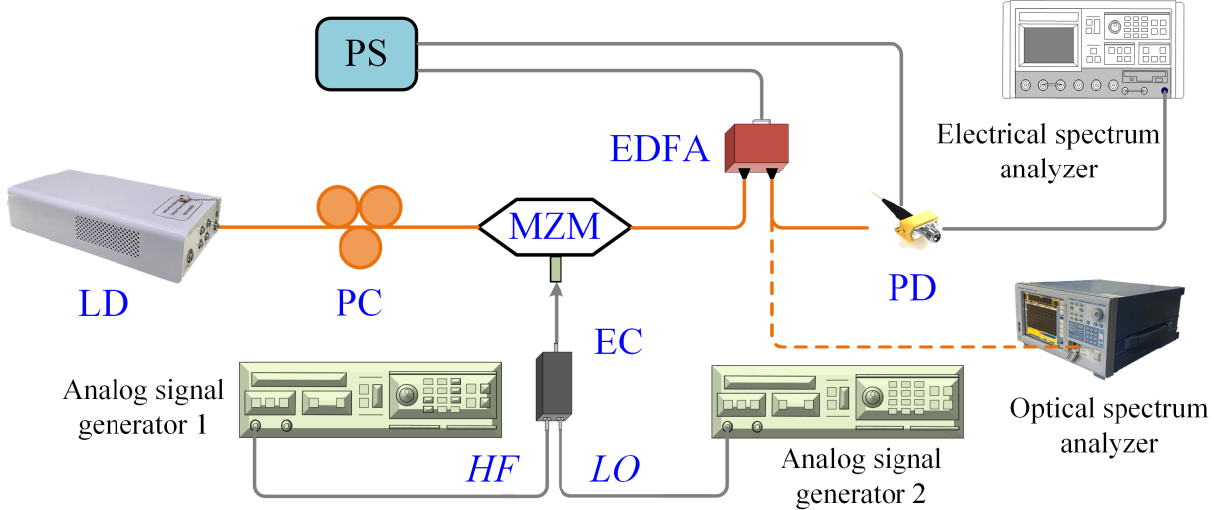
Figure 5. Experimental link setup based on the proposed converter (PS: power source; PC: polarization controller).